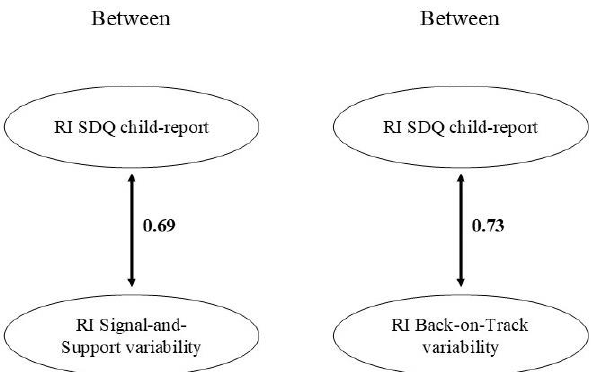
Figure 4. Significant associations from the RI-CLPMs with SDQ child-report. Standardized esti- mates are presented. RI = Random intercept; SDQ = Strengths and Difficulties Questionnaire, total problems scale.